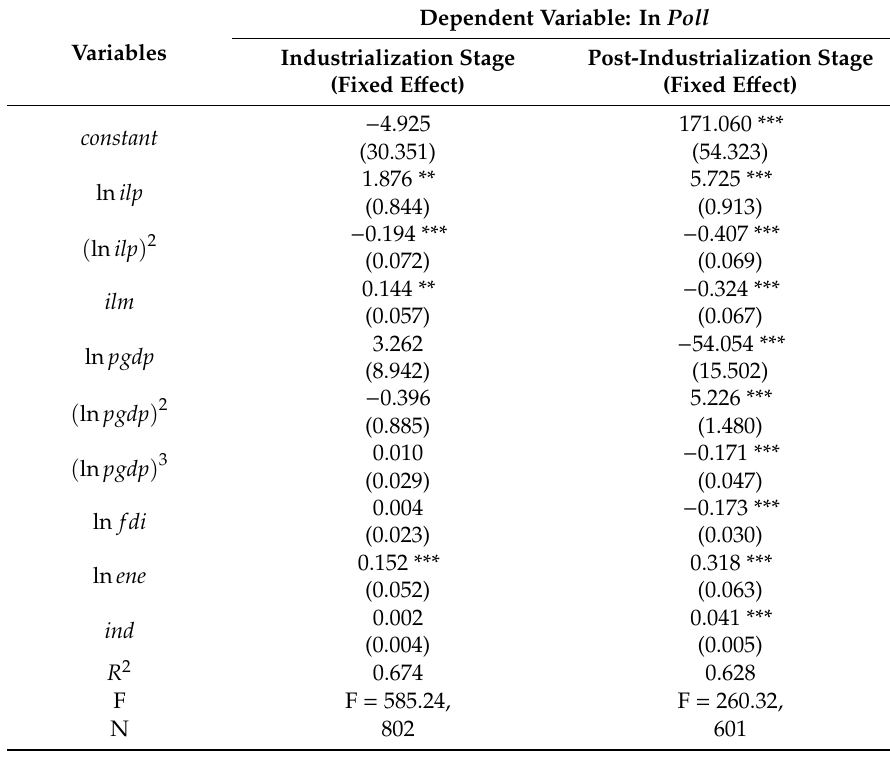
Table 3. Estimation results of grouped sample